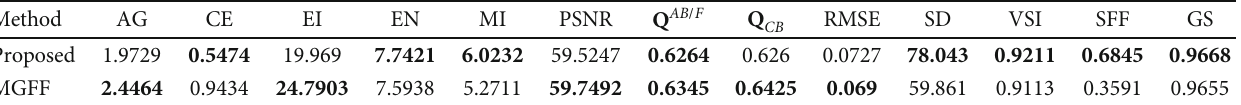
Table 6: Average evaluation metric values of the MGFF method and the proposed method on stray light noise of the SDD dataset. The best values of each metric are marked as